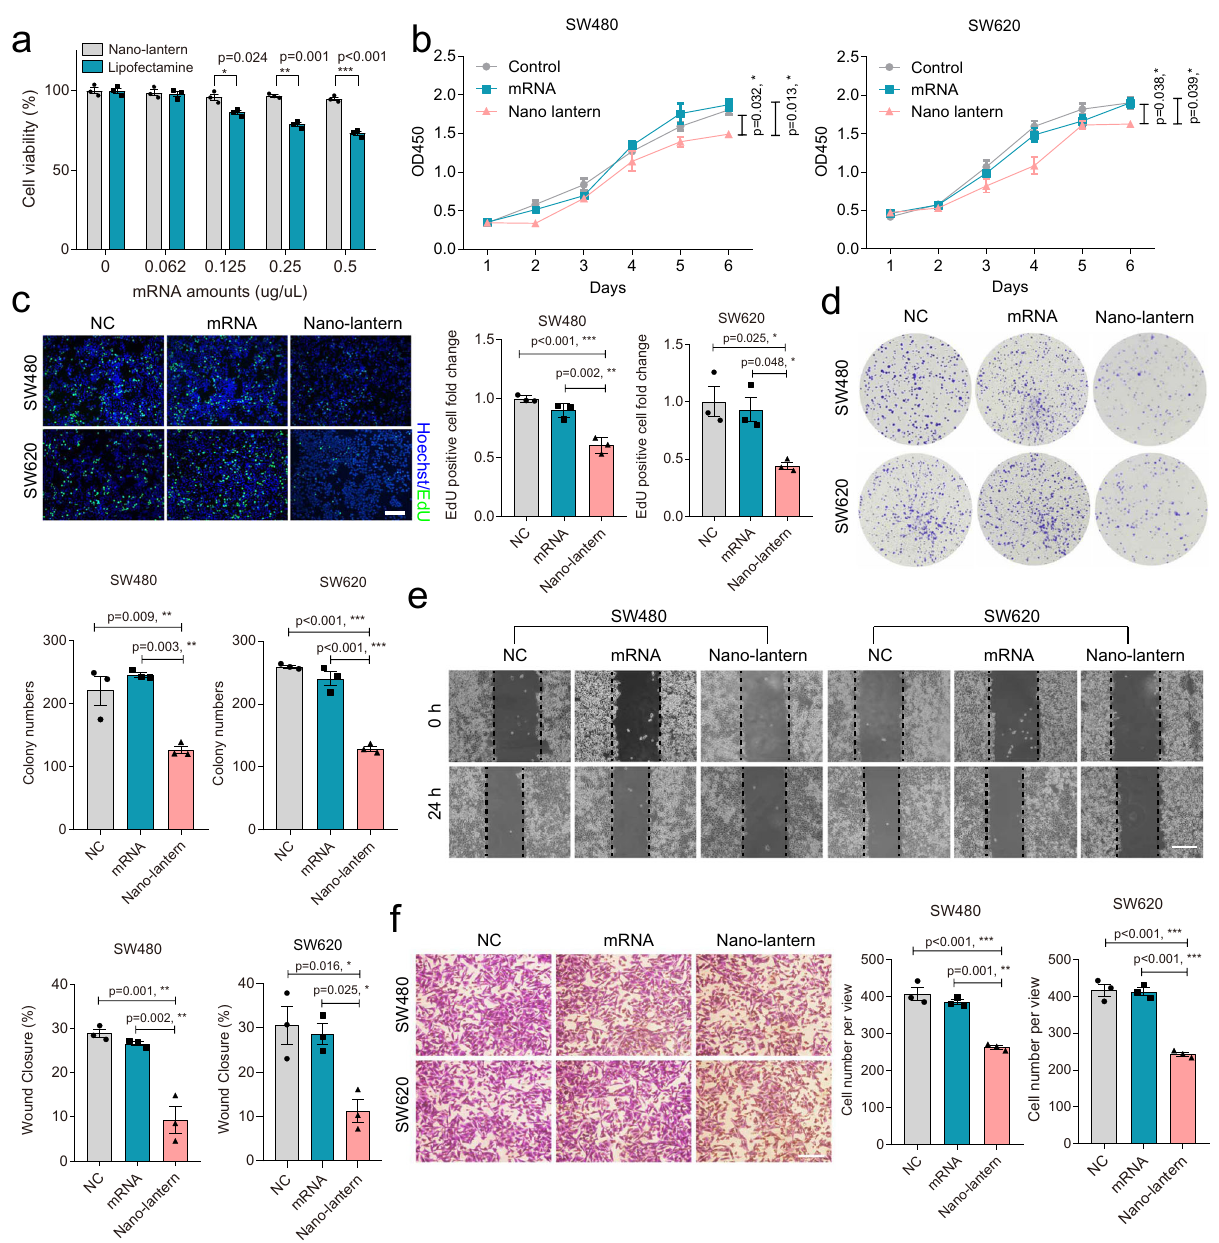
Fig. 6 | Smad4 mRNA nano-lantern introduction correlates with reduced pro- liferation, clonogenicity and migration in vitro. a Cell viability assays of SW480 cells treated with Lipo+Uu-mRNA and nano-lantern with Uu-mRNA for 24h, respectively. b – d ThecellproliferationabilityofSW480andSW620cellsincubated with individual Smad4 mRNA or mRNA nano-lantern by ( b ) CCK8 assay, ( c ) EdU assay,Scalebar:100 μ m,and( d )platecolonyformationassay. e Thecellmigration abilityofSW480andSW620cellsincubatedwithindividual Smad4 mRNAormRNA